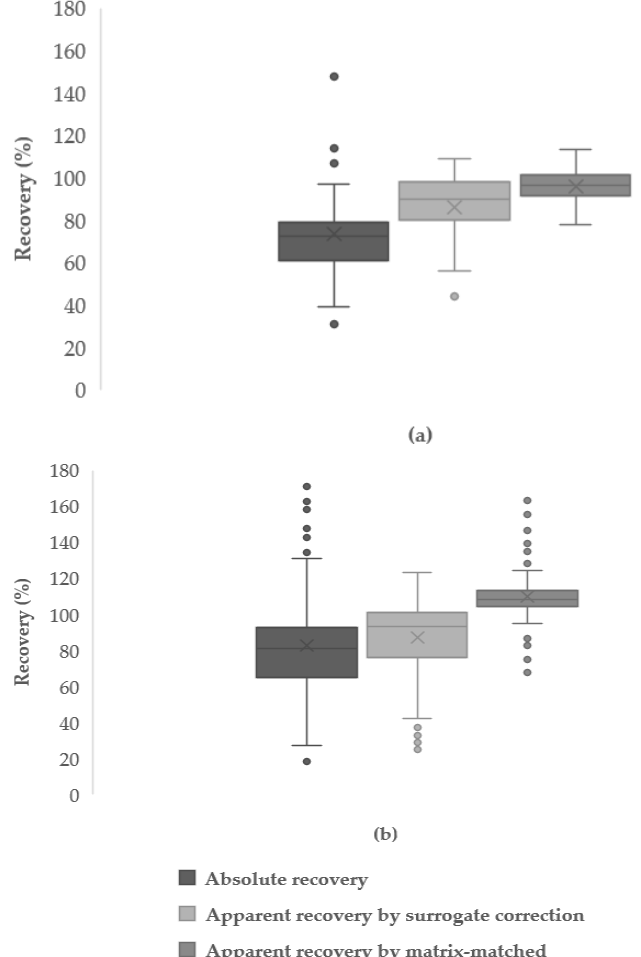
Figure 2. Absolute and apparent (surrogate correction and matrix-matched) recoveries (%) spiking milk samples at: ( a ) 10 ng/g and ( b ) 40 ng/g.